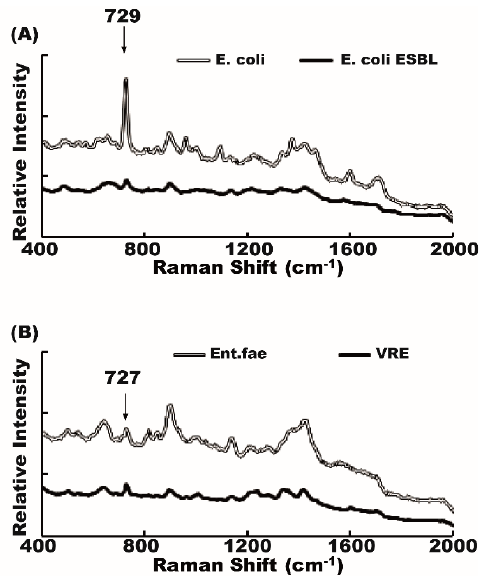
Figure 4. Raman spectra of antibiotic-susceptible and antibiotic-resistant bacteria. The Raman shift spectra of antibiotic-susceptible and antibiotic-resistant strains were similar. ( A ) E. coli and E. coli ESBL , ( B ) Enterococcus faecalis and vancomycin-resistant Enterococcus ( VRE ).